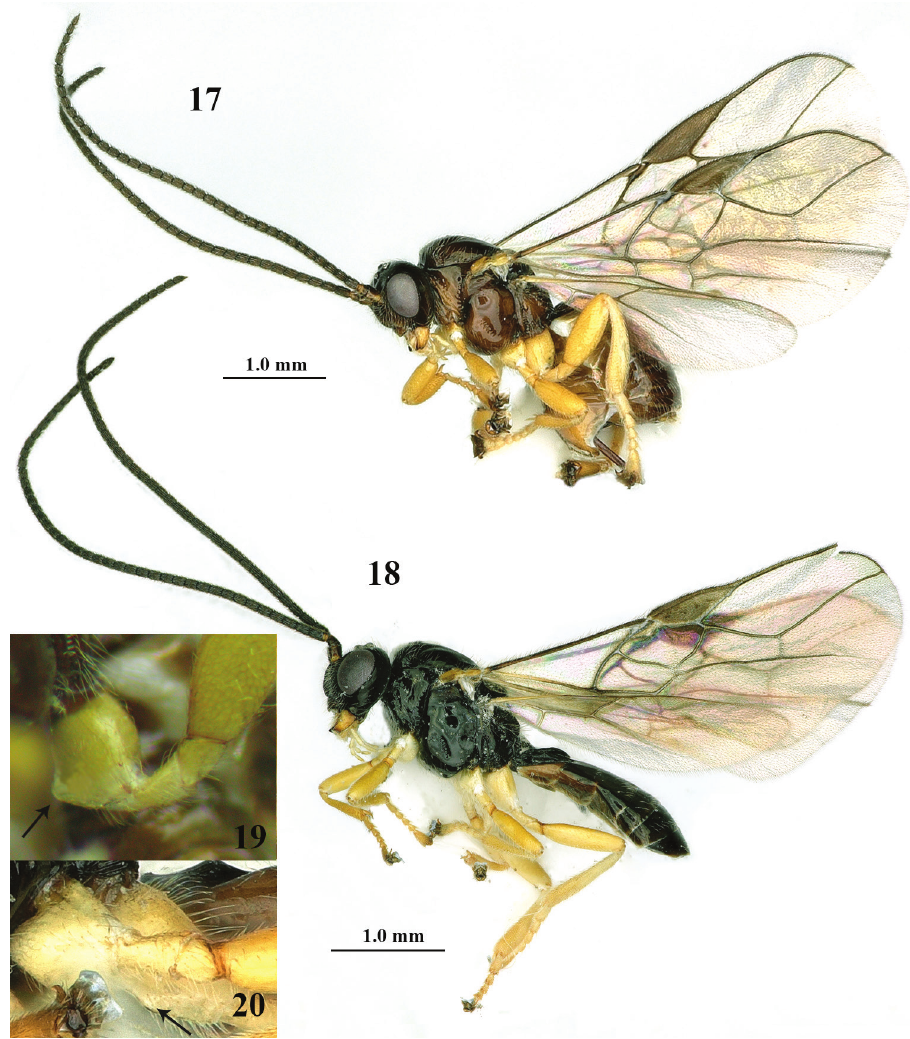
Figures 17–20. Nipponopius glabricaudatus sp. n., ♀ , holotype, but 18 and 20 of ♂ , paratype. 17, 18 habitus lateral 19, 20 hind coxa lateral (arrow pointing to coxal protuberance). smooth except posterior margin shortly crenulate; dorsal surface of propodeum short, punctate-rugose, and with a short medio-longitudinal carina connected to an irregular transverse carina, its posterior surface largely punctate-reticulate (Fig. 23). Wings . Fore wing: pterostigma elliptical; vein r issued just before middle of ptero- stigma (Fig. 21); r:2-SR:3-SR:SR1 = 3:15:21:36; SR1 slightly curved;1-CU1:2-CU1 = 1:6; CU1b shorter than 3-CU1; m-cu postfurcal;1-CU1 hardly widened. Hind wing: M+CU:1-M:1r-m = 21:21:14; cu-a straight (Fig.